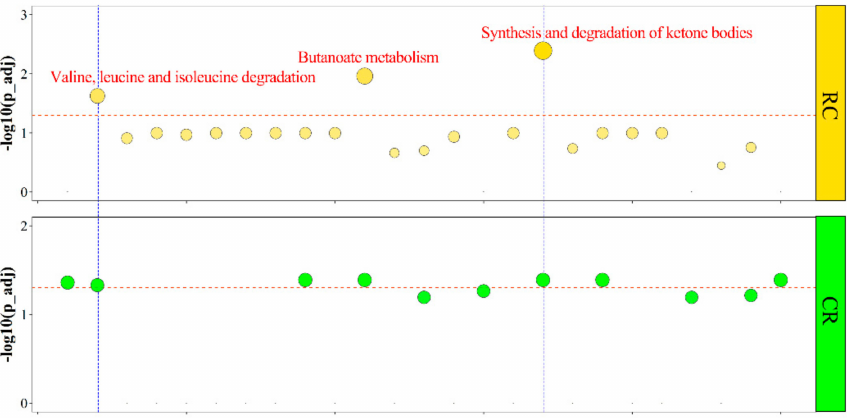
Figure 3. Kyoto Encyclopedia of Genes and Genomes (KEGG) pathway analysis of over-dominant genes for the RC and CR groups. Each KEGG pathway is represented by a dot. The area of a dot represents the number of genes enriched in the pathway. The dashed orange lines represent significant levels (adjusted p -value < 0.05). Dots that pass the blue dashed line represent significant KEGG pathways. Descriptions of the significant pathway are displayed above the